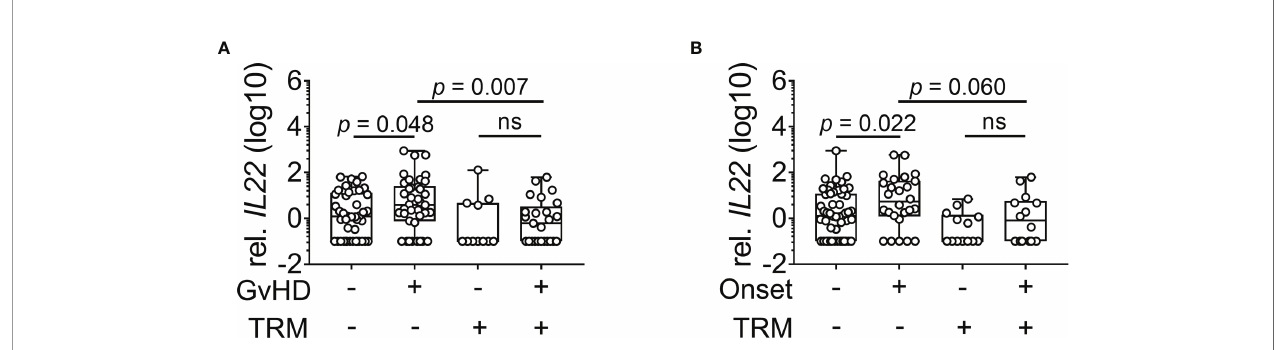
FIGURE 1 | IL22 expression in dependence of GvHD and TRM. Patients were grouped according to absence or presence of TRM. IL22 gene expression normalized to 18s rRNA was measured. (A) Expression of IL22 in patients during histological GI-GvHD (no TRM: n = 82, TRM: n = 36). (B) Expression of IL22 in patients without and during clinical onset of GvHD (no TRM: n = 78, TRM: n = 27). Box plot diagrams depict median, upper, and lower quartiles and whiskers indicate minimal and maximal values. Negative values were set to 0.1. Statistical testing was performed using Mann-Whitney U test. ns, not signi fi cant.